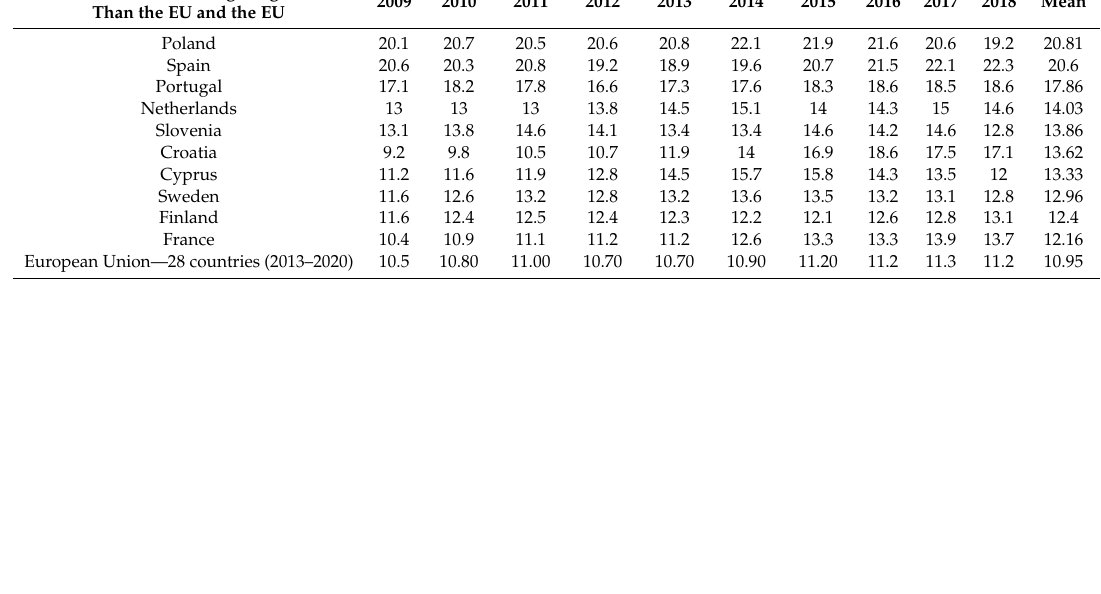
Table A1. Persons with limited-duration contracts—percentage of total employment (Eurostat 2019a). Countries with an Average Higher Rate Than the EU and the